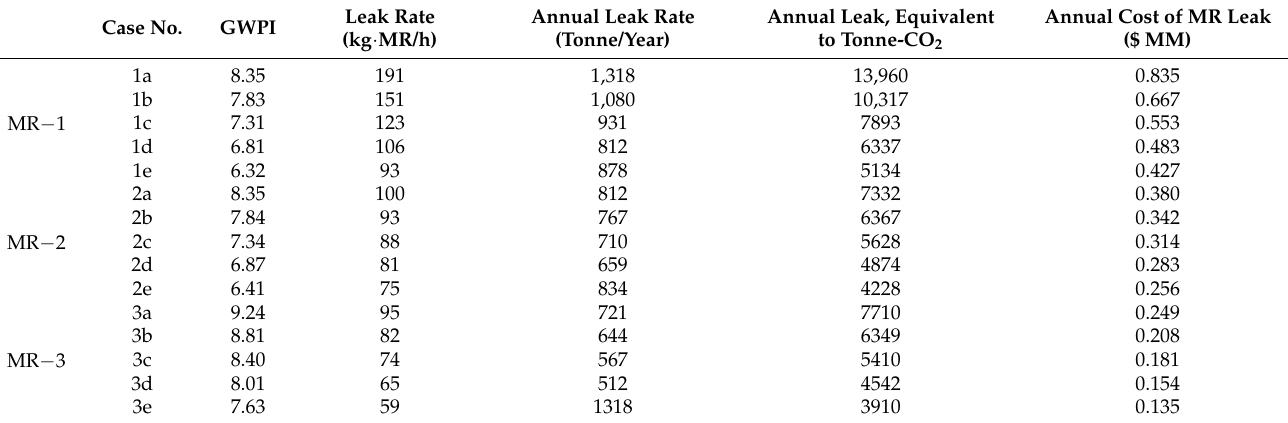
Table 11. GWPI, mixed refrigerant annual leak rates and annual costs of each case study. Case